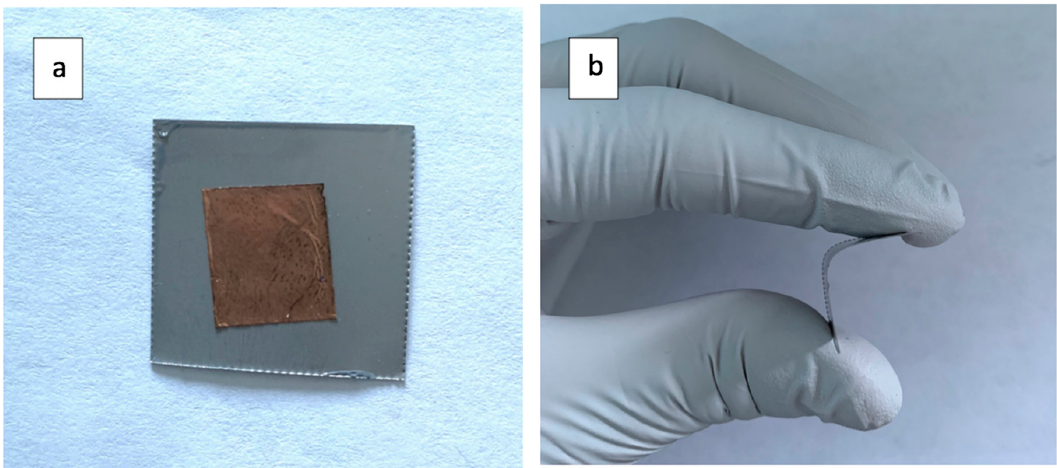
Figure 4. ( a ) Final fabricated flexible nanocomposite thin film, ( b ) 90 ◦ bend (showing the flexibility).